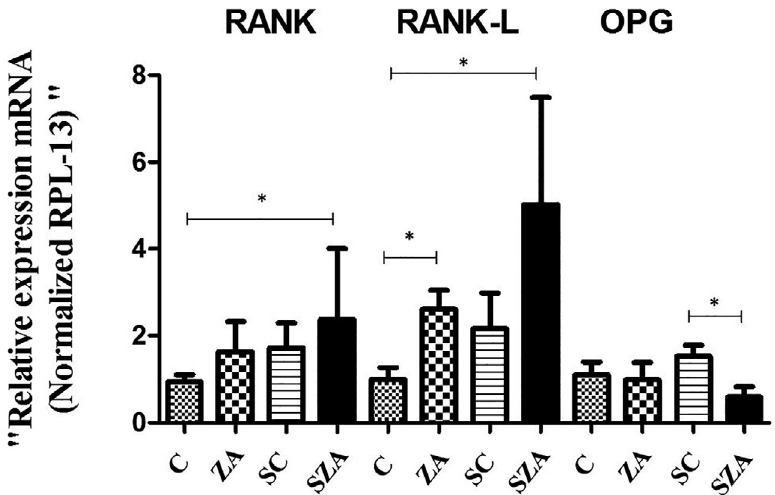
Figure 7- Expression of bone markers for levels of osteoclast expression for RANK, RANKL, and OPG, analyzed by qPCR. Results are presented as mean values ± SD of CT of the studied targets, normalized by RPL-13 expression, obtained from six animals of each